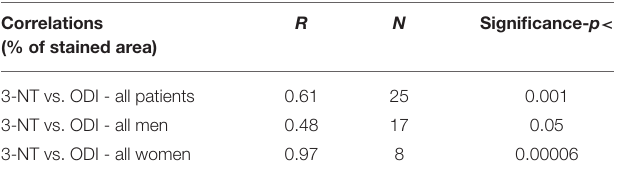
R N Significance- p